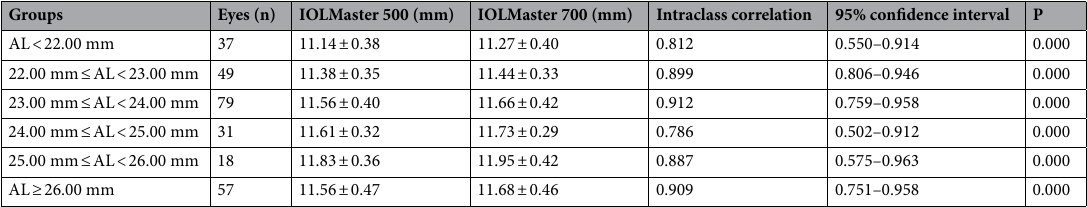
Table 6. The results of IOLMaster 500 and IOLMaster 700 in WTW measurement and ICC analysis.